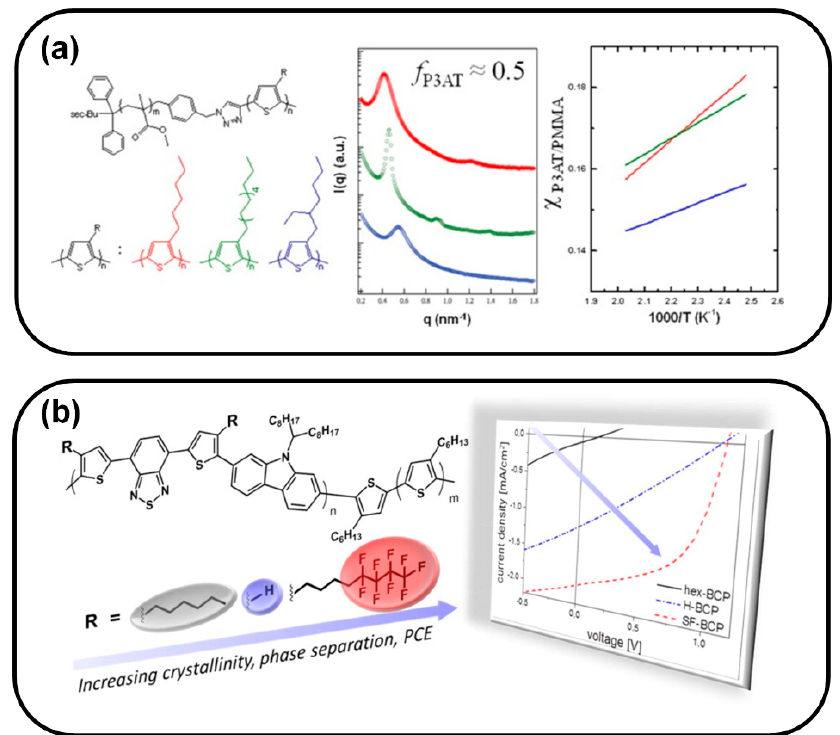
Figure 13. ( a ) Chemical structures of P3AT- b -PMMAs with different side chain length, Small-angle X-ray scattering results and temperature dependence of the Flory–Huggins interaction parameter between P3AT and PMMA segments for P3AT- b -PMMA; (Reprinted with permission from Ref. [118]. Copyright American Chemical Society); ( b ) chemical structure of PCDTBT- b -P3HT with different side chains and J – V characteristics. (Reprinted with permission from Ref. [119]. Copyright American Chemical Society).